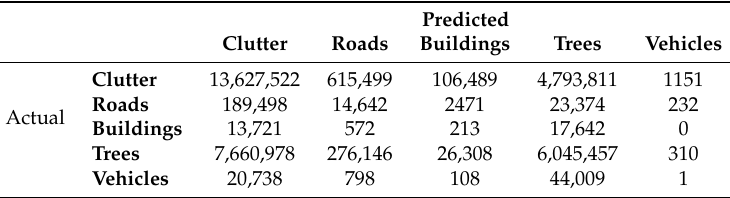
Table A14. Confusion matrix for the GSCNN model that is trained on coordinates and colors, and uses class weights, after 400 epochs.